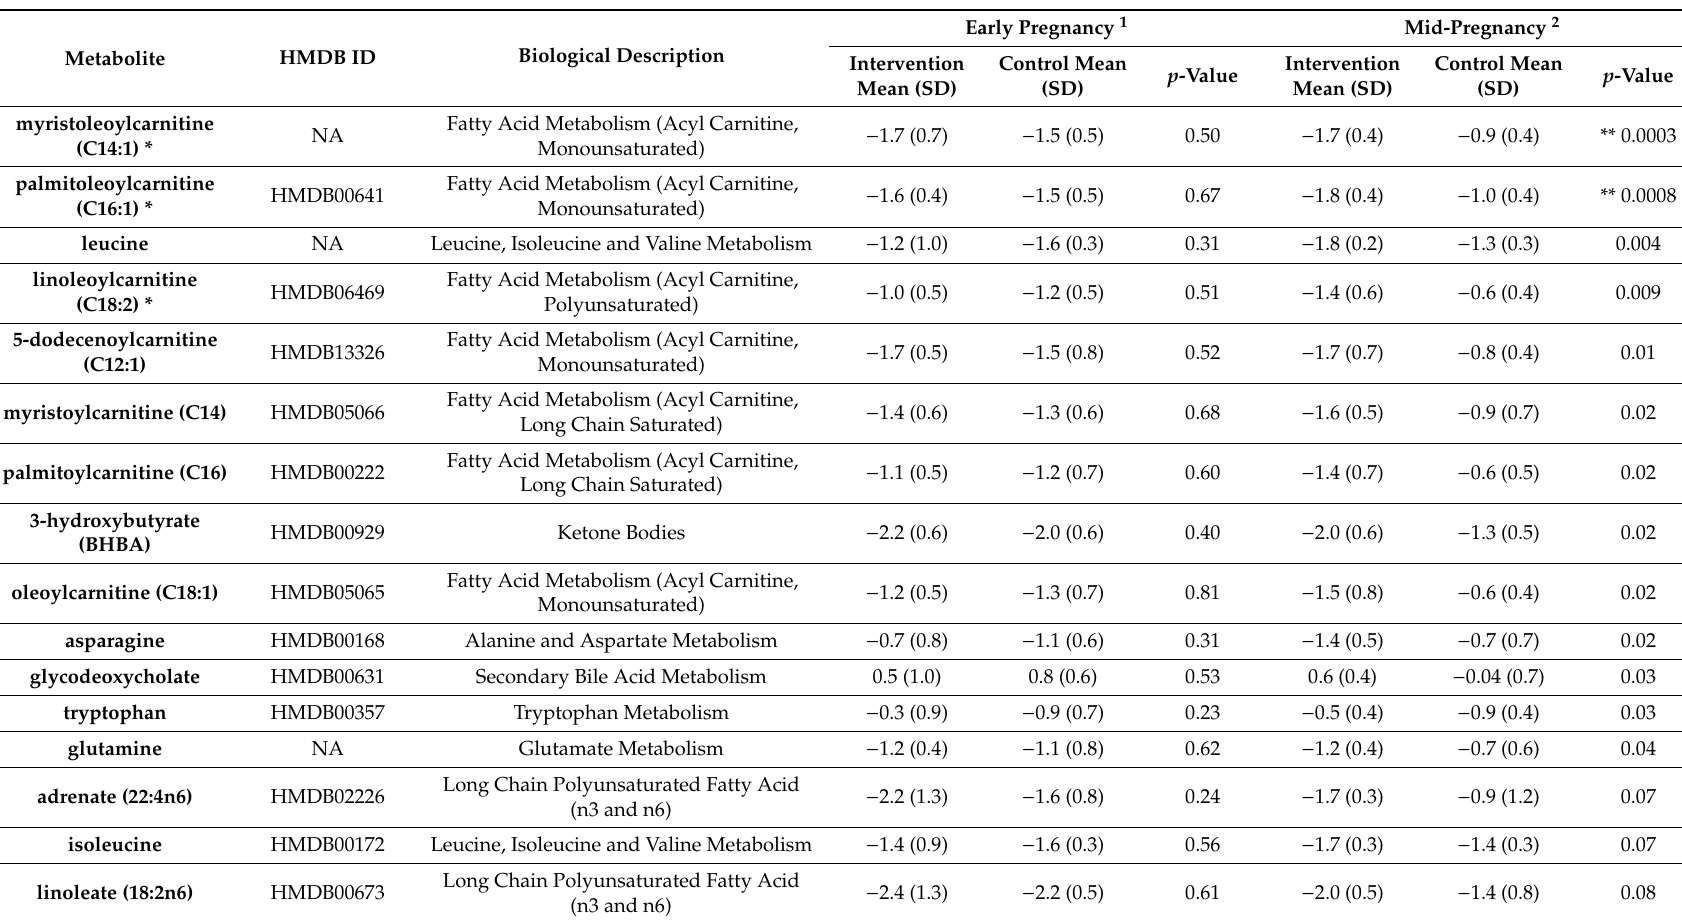
Table 2. Mean di ff erence at fasting compared to 120 min post-OGTT ( ∆ fast-120 min) for targeted metabolites in intervention versus control arm among PEARLS participants at early and